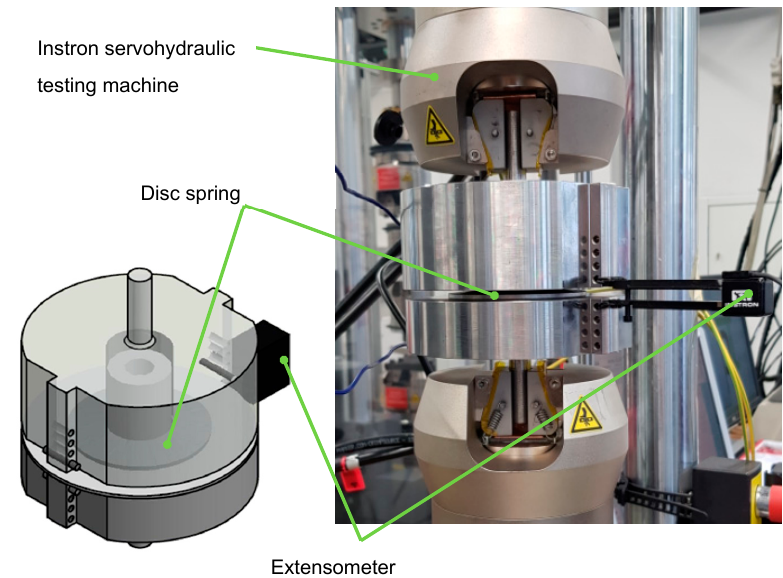
Figure 5. Experimental set-up for the quasi-static and cyclic testing of the disc springs.